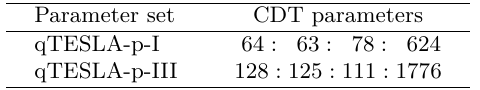
Table 2: CDT parameters used in qTESLA’s Round 2 implementation (targeted precision β : implemented precision in bits : number of rows t : table size in